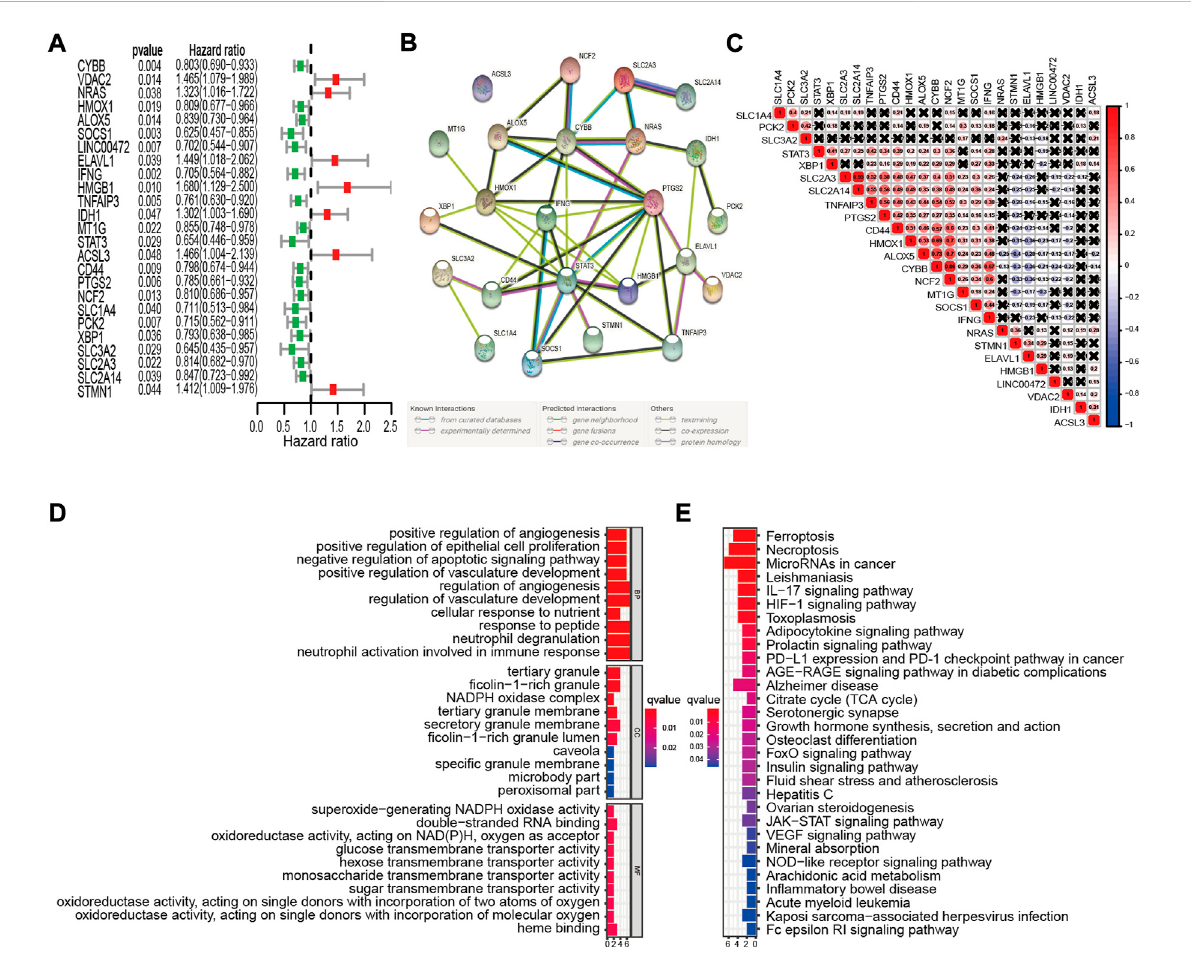
FIGURE 2 Identi fi cation of prognostic FRGsin the GSE32062 cohort. (A) Forest plots of HRs and 95% CIs of theassociation betweenFRGsexpressionand OS. (B) A PPI network showing the interactions among the prognostic FRGs. (C) FRGs correlation network. (D,E) The most signi fi cantly enriched GO terms (D) and KEGG pathways (E) are displayed. FRG, ferroptosis-related gene; HR, hazard ratio; CI, con fi dence interval; OS, overall survival; PPI, protein-protein interaction; GO, Gene Ontology; KEGG, Kyoto Encyclopedia of Genes and